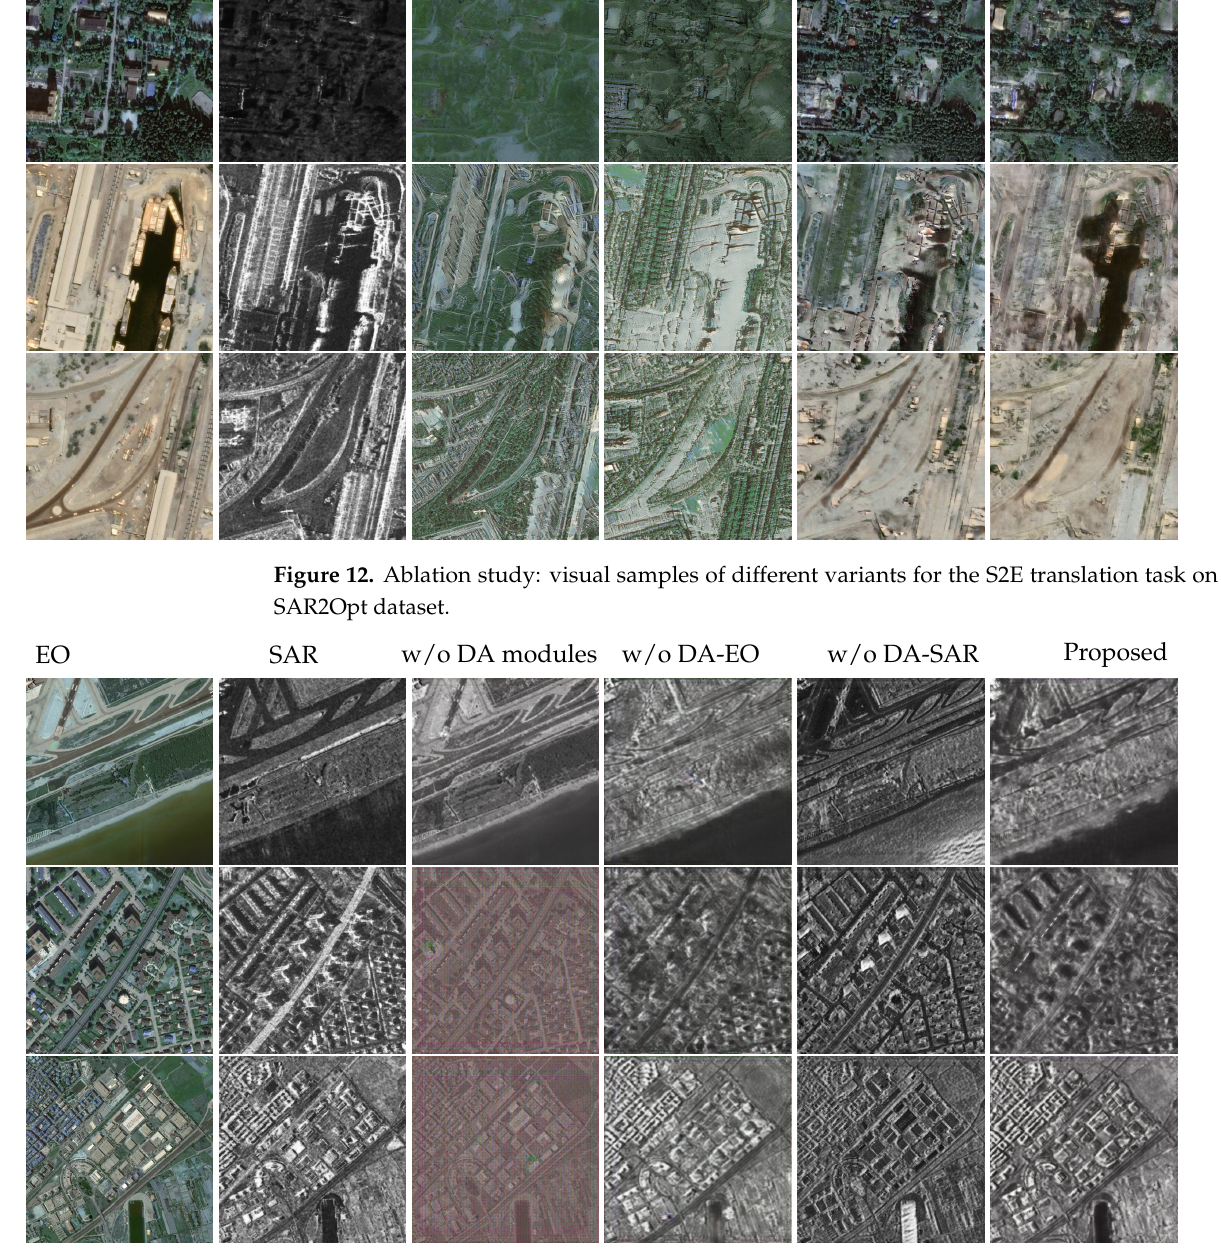
Figure 13. Ablation study: visual samples of different variants for E2S translation task on SAR2Opt